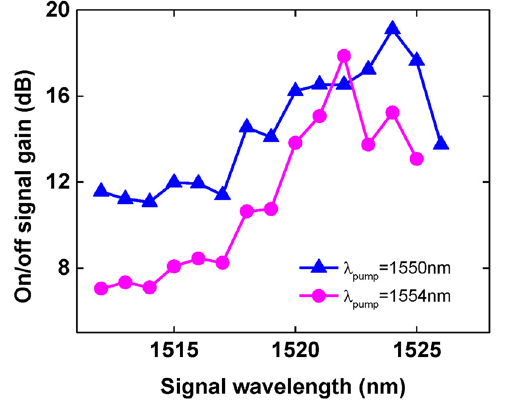
Figure 7: Comparison of on/off signal gains between pump wavelength ( λ pump ) of 1550 and 1554 nm. The blue triangular line is the same as the pink dots at the shorter wavelength region in Figure